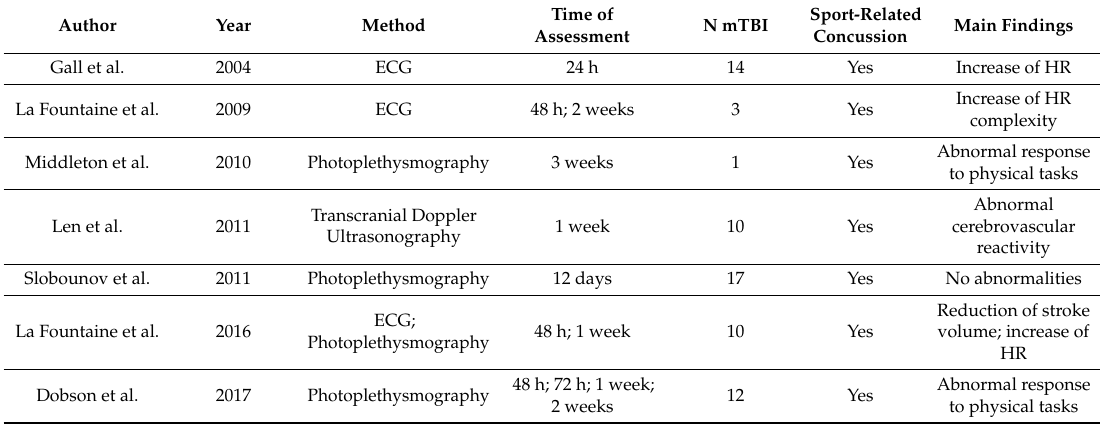
Table 1. Hemodynamic response to tasks or stress within 4 weeks from concussion.